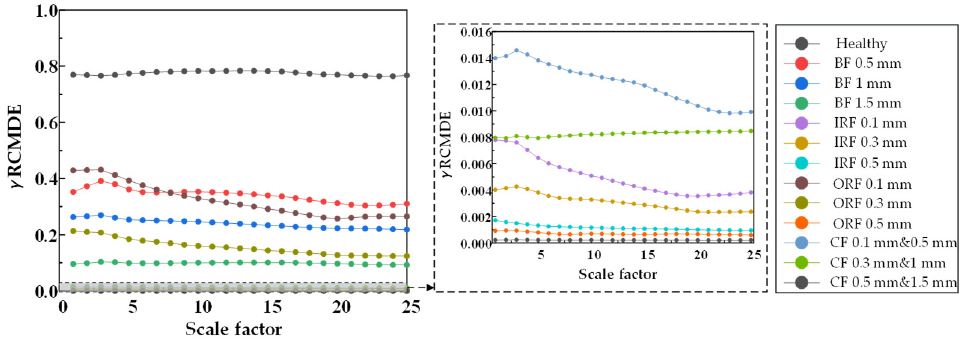
Figure 30. γ RCMFE entropy values of 25 scale factors under different damage degrees.